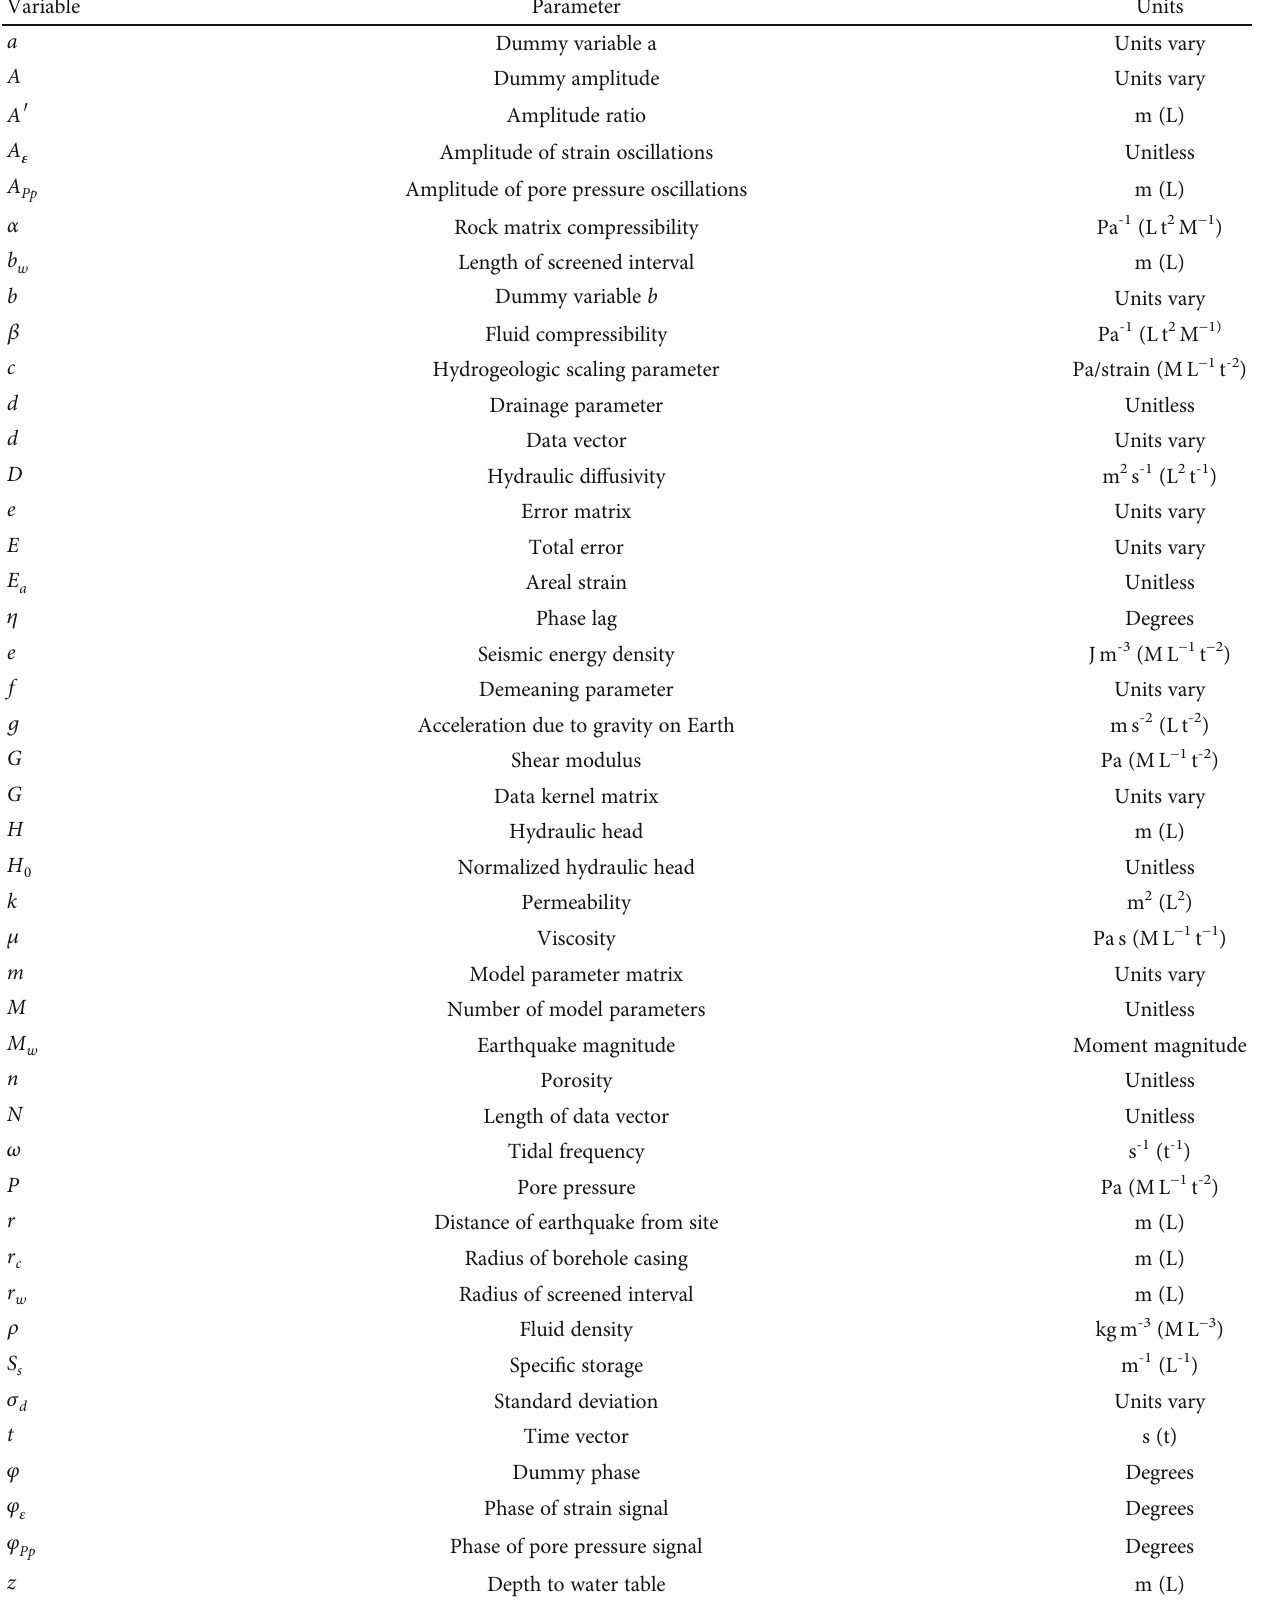
Table 1: De fi nition of